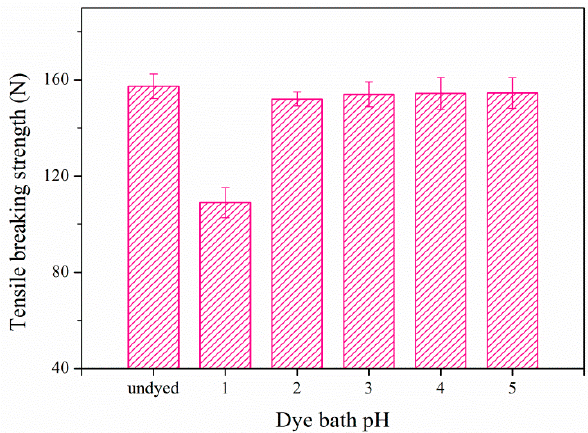
Figure 6. Effect of dye bath pH on tensile breaking strength of dyed cotton fabric.